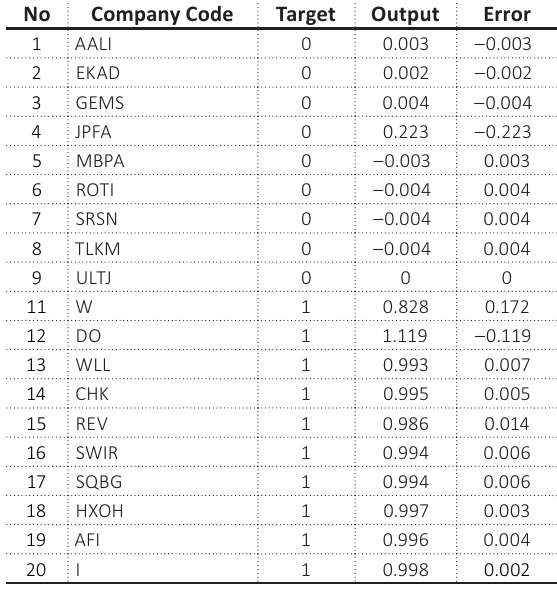
Table 7. Results of financial